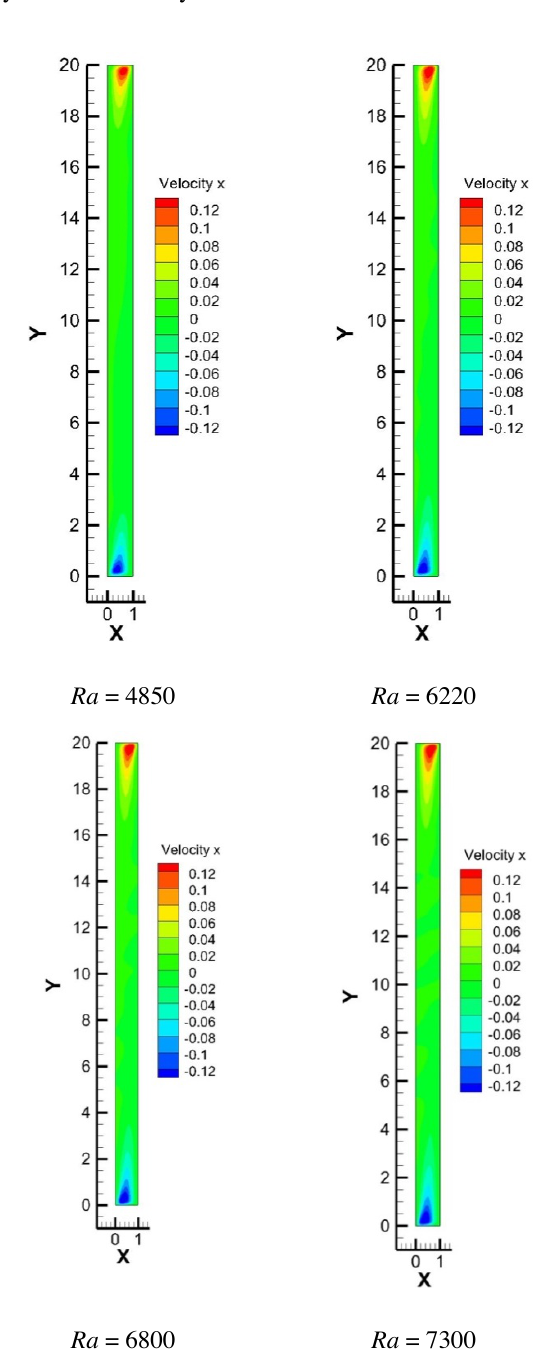
Fig. 3. Fields of longitudinal velocity in the vertical cross- section of the calculated area for different Rayleigh numbers .